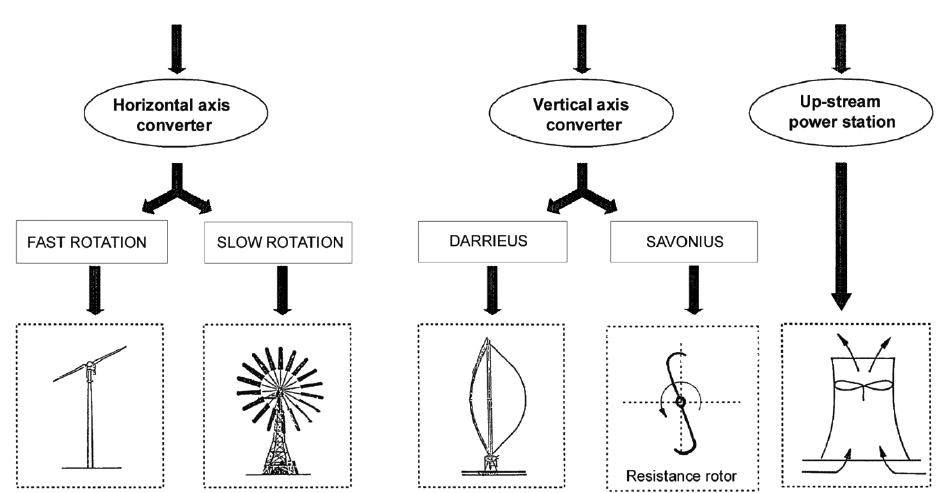
Fig. 1. – Overview of the different types of wind